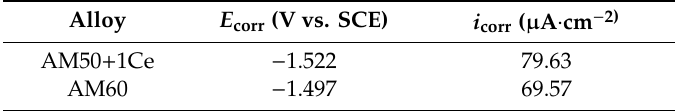
Table 2. Fitting results from polarization curves of HPDC AM50 + 1Ce and AM60 magnesium alloys in 3.5 wt% NaCl solution.